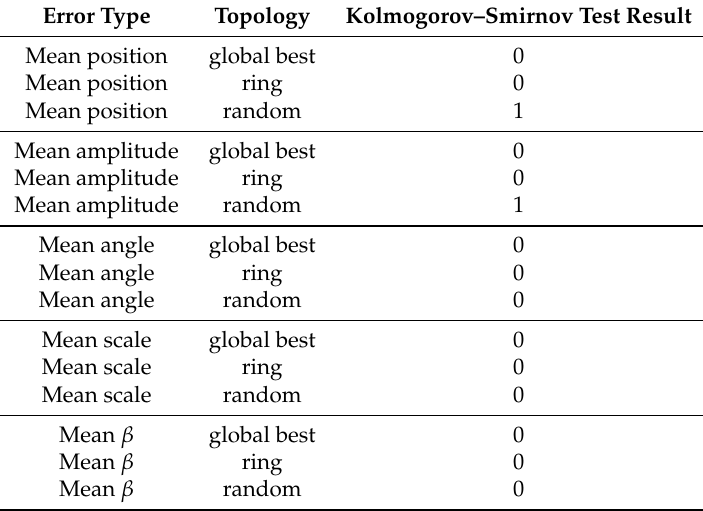
Table 4. Two-sample Kolmogorov–Smirnov tests: ideal and noised volumes (0—rejection of the null hypothesis).